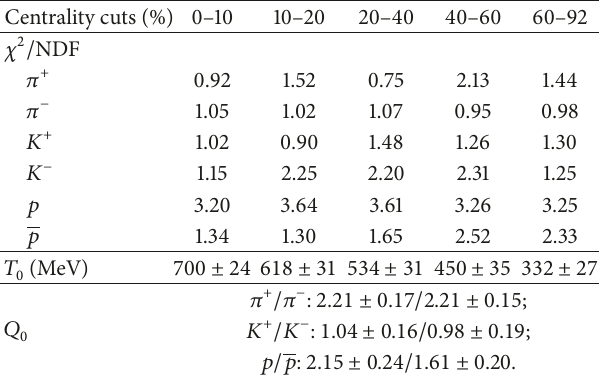
Table 1: The 𝜒 2 / NDF and the fitted initial temperature 𝑇 0 and constant 𝑄 0 at 68.3% confidence level in different centrality Au-Au collisions at √𝑠 NN = 200